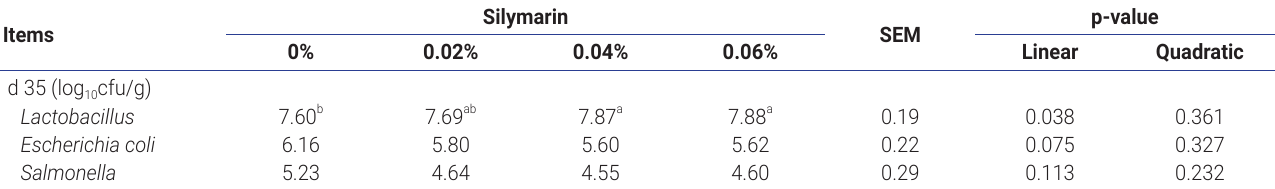
Table 4. The effect of Silymarin supplementation on microbes in